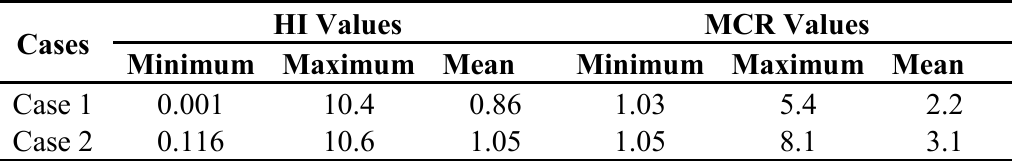
Table 6. HI and MCR values in the final dataset of 618 mixtures. Statistical